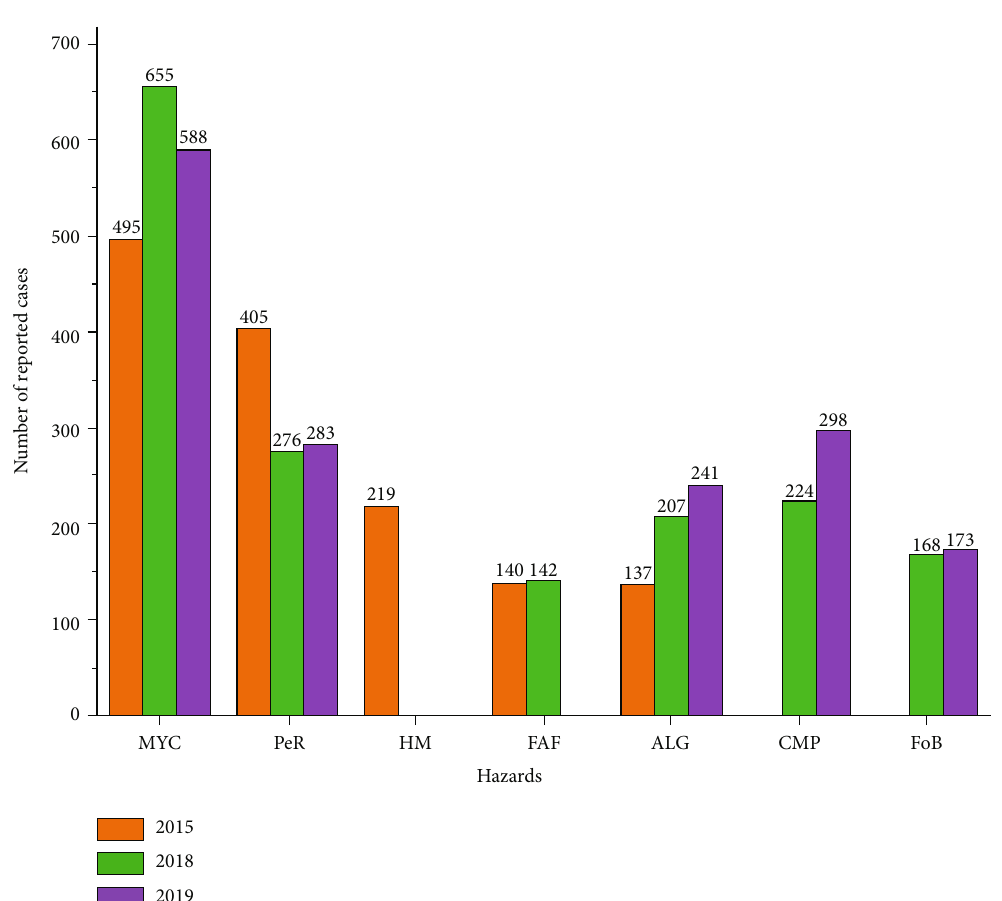
Figure 4: Hazard noti fi cation trends as reported by the RASFF annual report. Source: RASFF annual report [28, 38, 39]. MYC=Mycotoxins; PeR=Pesticide residues; HM=Heavy metals; FAF=Food additives and fl avourings; ALG=Allergens; CMP=Composition; FoB=Foreign bodies.